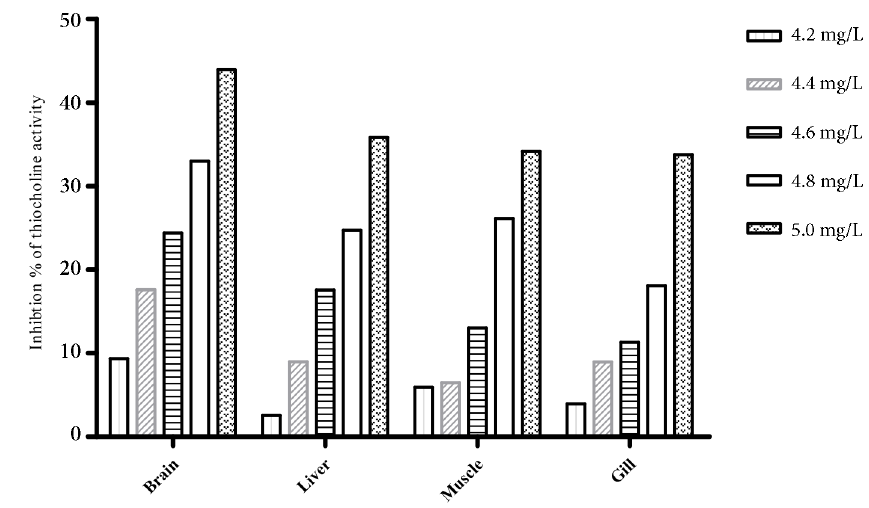
Figure 2. Percent inhibition of AChE activity in the tissues of the A. testudineus after exposure to different concentrations of